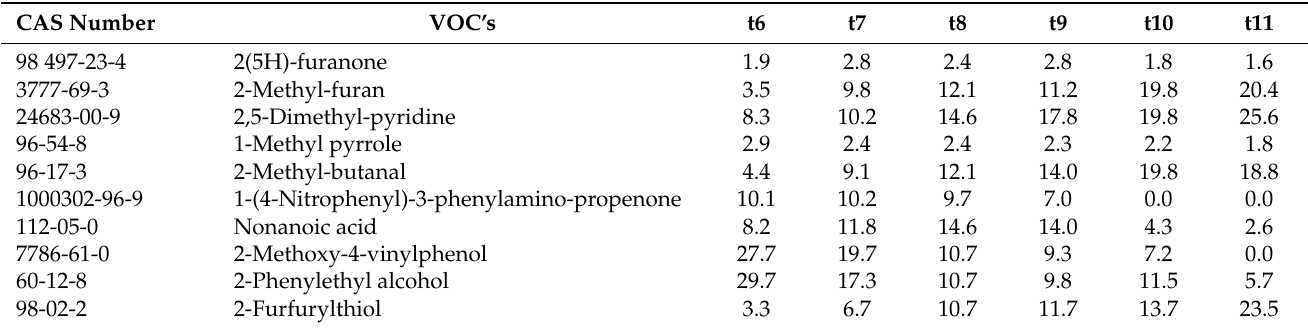
Table 4. Relative percentage of volatile compounds (VOCs) obtained for roasted coffee beans submit- ted to different thermal treatments (t6–t11).